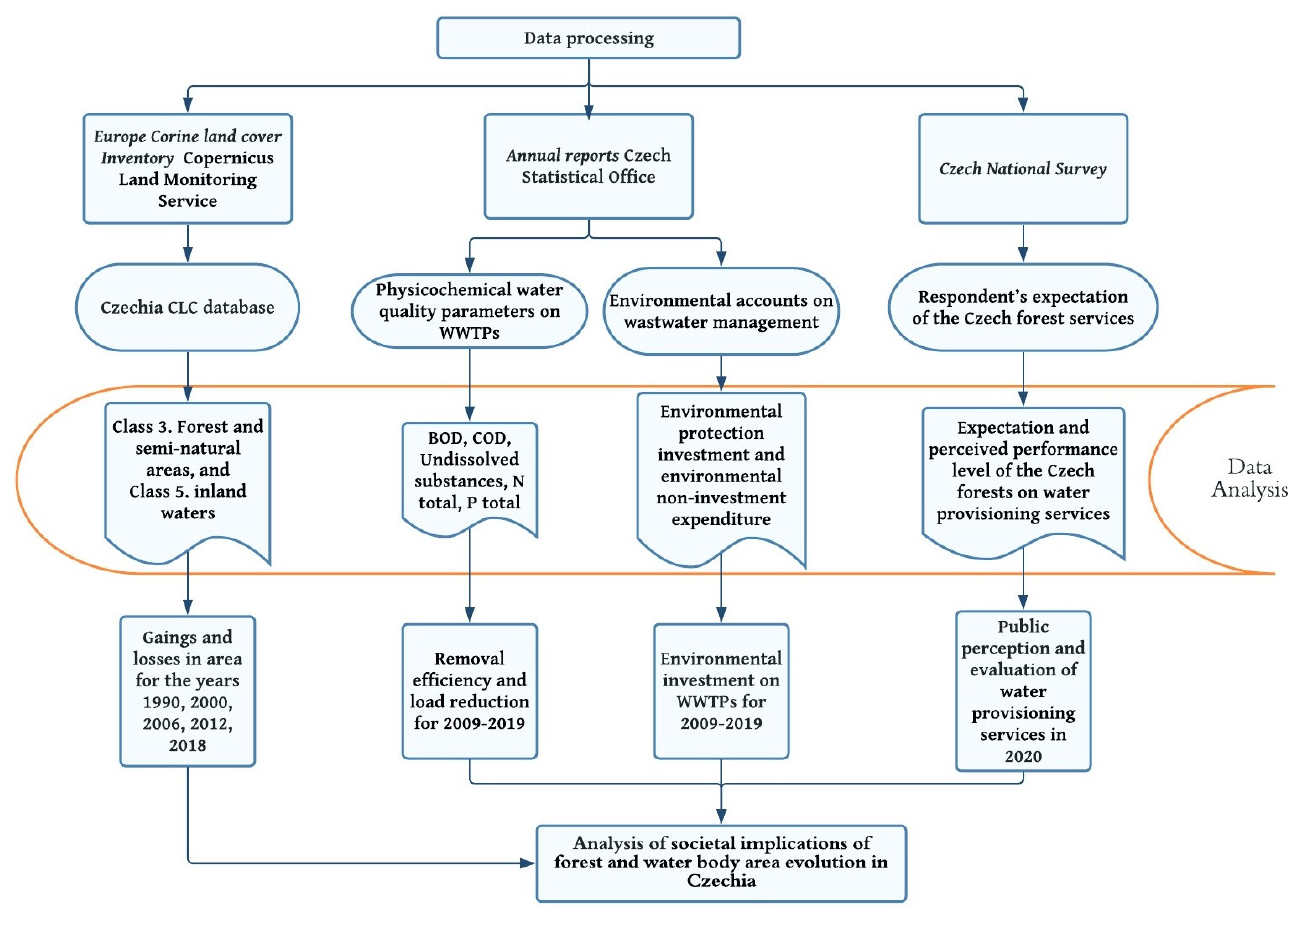
Figure 2. Data processing.